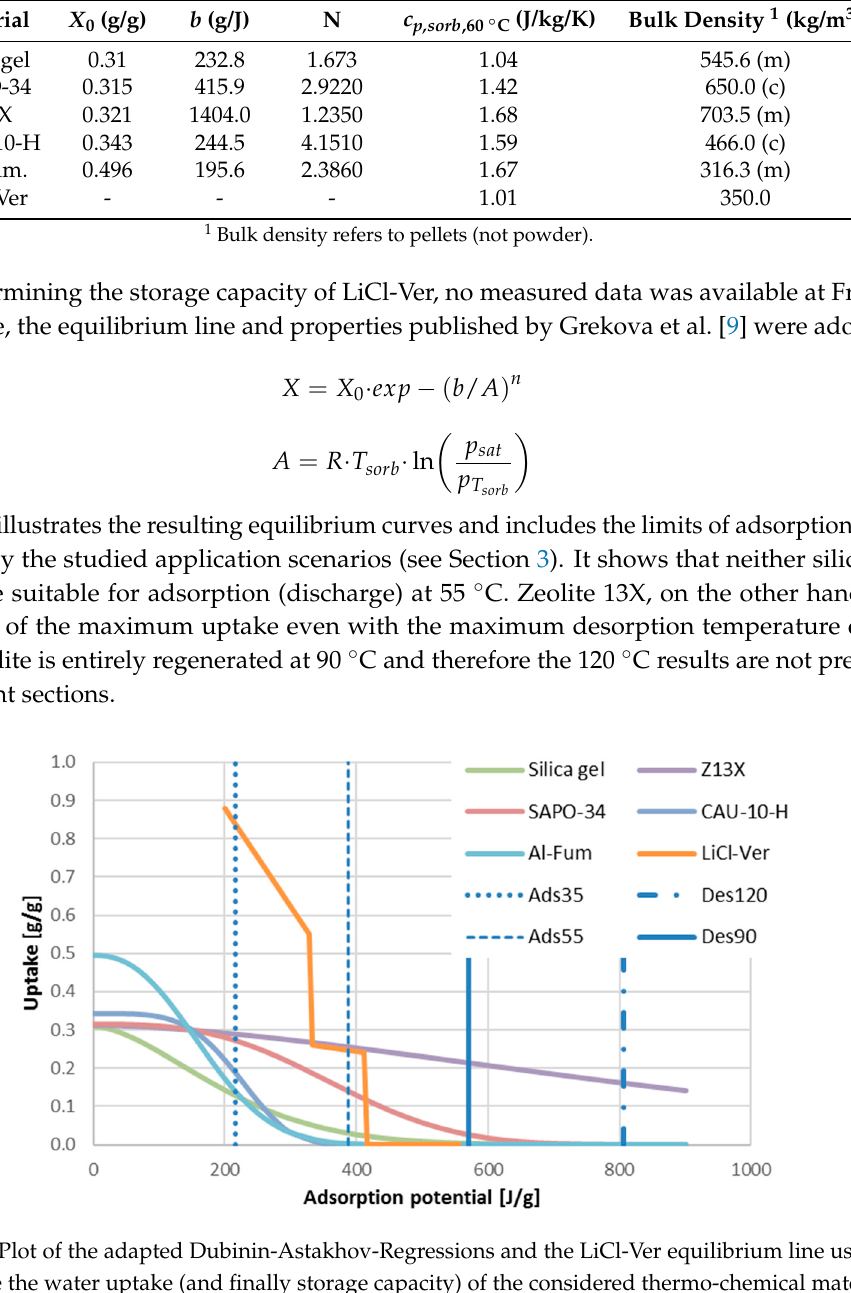
Table 2. Key information on the investigated materials; measured (m) and calculated (c) from the measured density of the powder, assuming close-packing of equal spheres with 74% of solid volume.